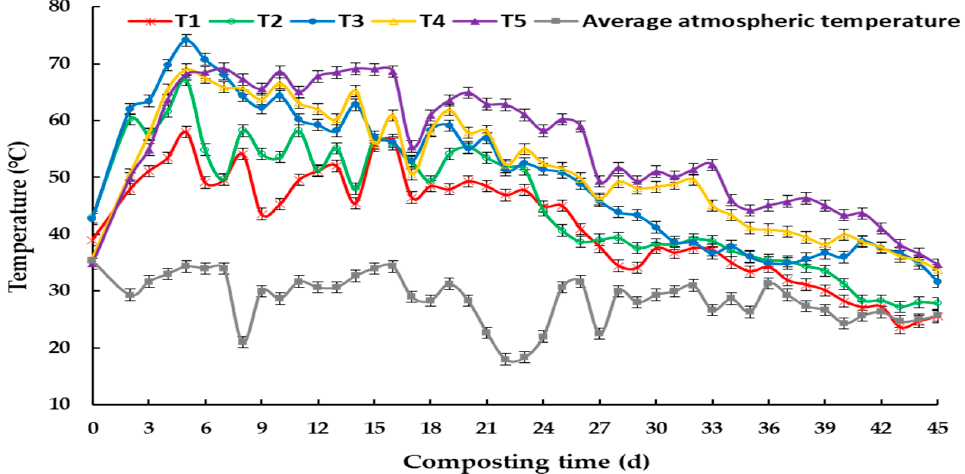
Figure 1. Changes in temperature during composting of corn straw and cow dung under different C/N ratios.